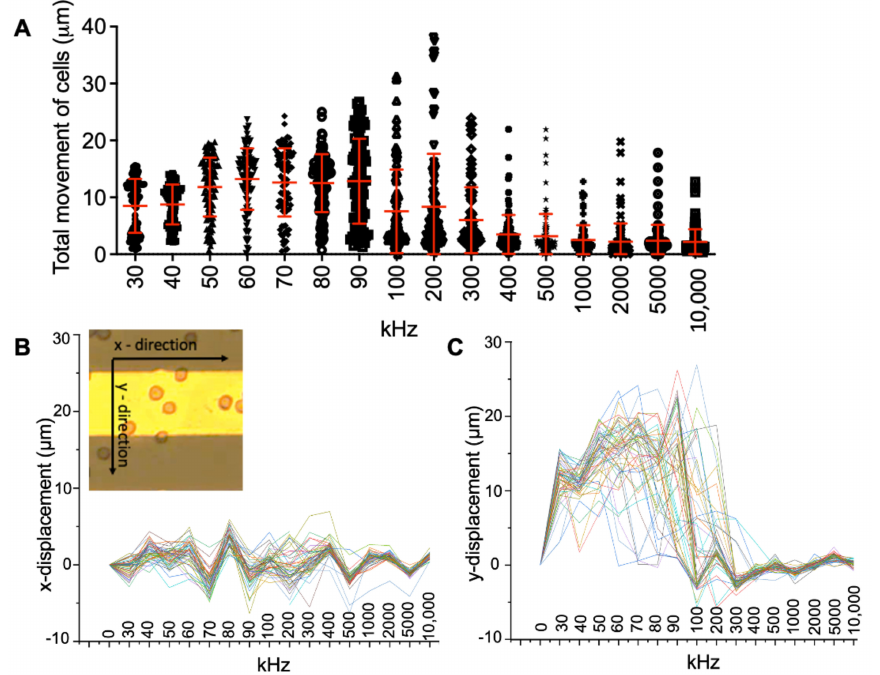
Figure 4. Dielectrophoretic displacement of U87 glioma cell population. ( A ) Distribution of total displacement, movement of glioma cells along ( B ) x -axis, and ( C ) y -axis when the cells were exposed to 3 V pp and 30 kHz–10 MHz frequencies. The inset shows the directions in the electrode array. The scale bar is 100 µ m. 100 glioma cells were analyzed at each frequency, the red bars show means ± standard